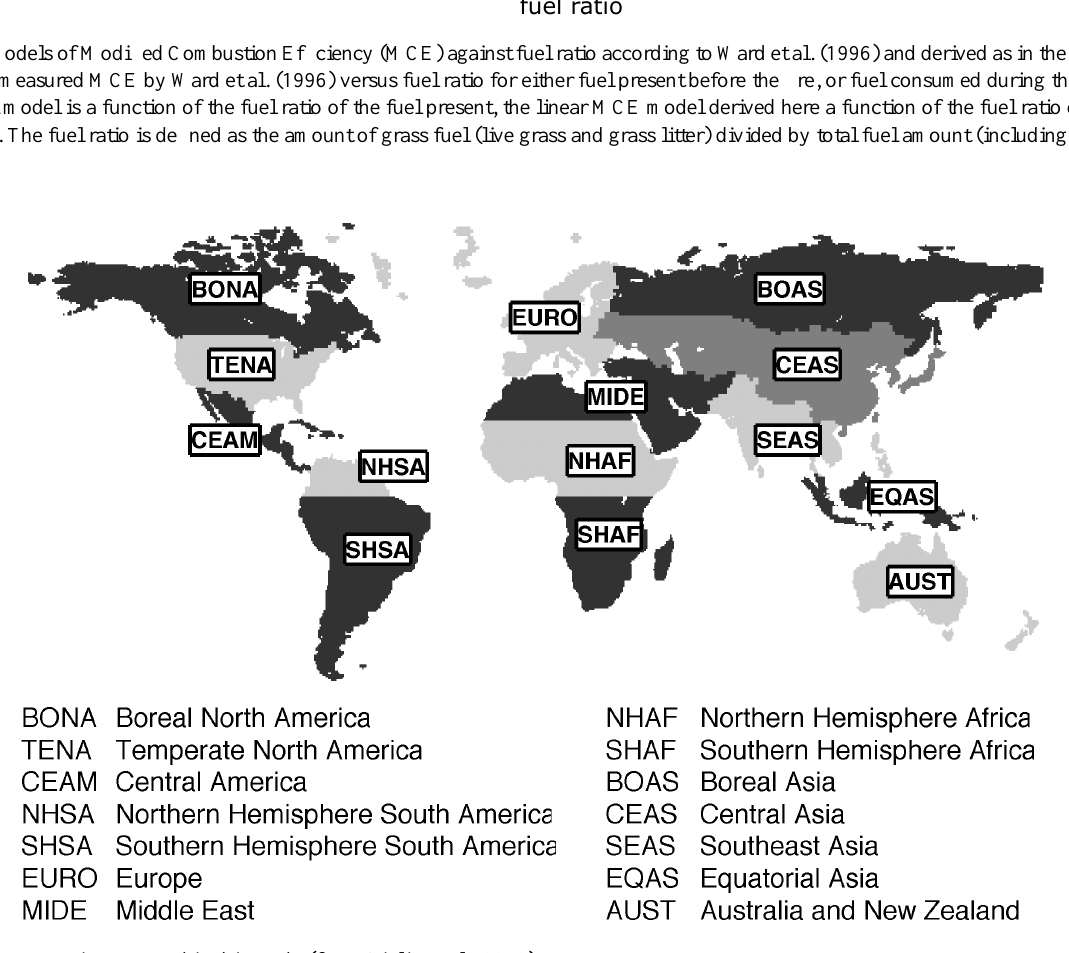
Fig. A2. GFED regions as used in this study (from Giglio et al., Fig. B1. GFED regions as used in this study (from Giglio et al., 2010).